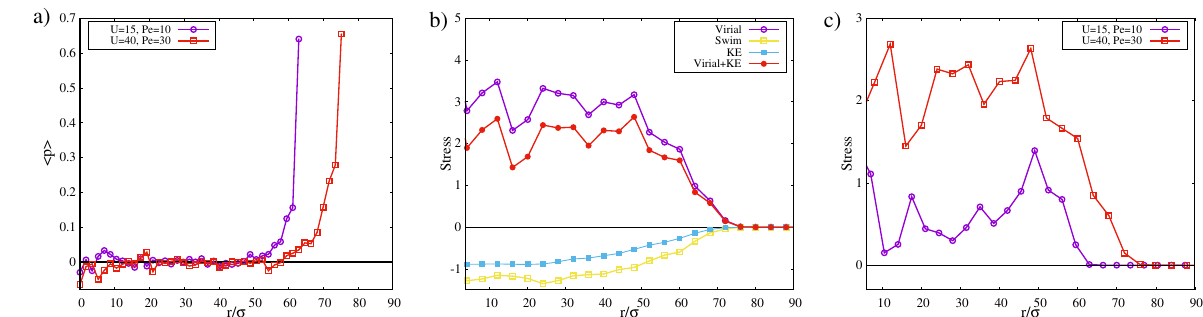
Fig. 3 Stress pro fi le. a Averaged polarization vector of the circular patch for (cid:1) σ ¼ 0 : 3 σ at L − V coexisting state for two different activity. b Different components of the stress pro fi le at (cid:1) σ ¼ 0 : 3 σ and U = 40, Pe = 30. “ Virial ” stress arising from cell – cell interactions (purple line), “ active ” stress due to propulsion, also called swim-stress (yellow line), “ kinetic ” (ideal gas') stress (light-blue line), and the total stress (virial + kinetic, red line) c The total stress pro fi le for different adhesive strength in L − V coexisting states at U = 15, 40. The stress is generated in the boundary region of the colony; outside of the colony, the stress vanishes.